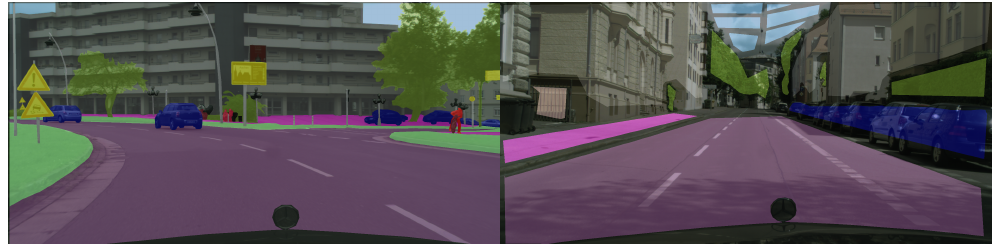
Figure 3. Example of finely ( left ) and coarsely ( right ) labeled Cityscapes [68]